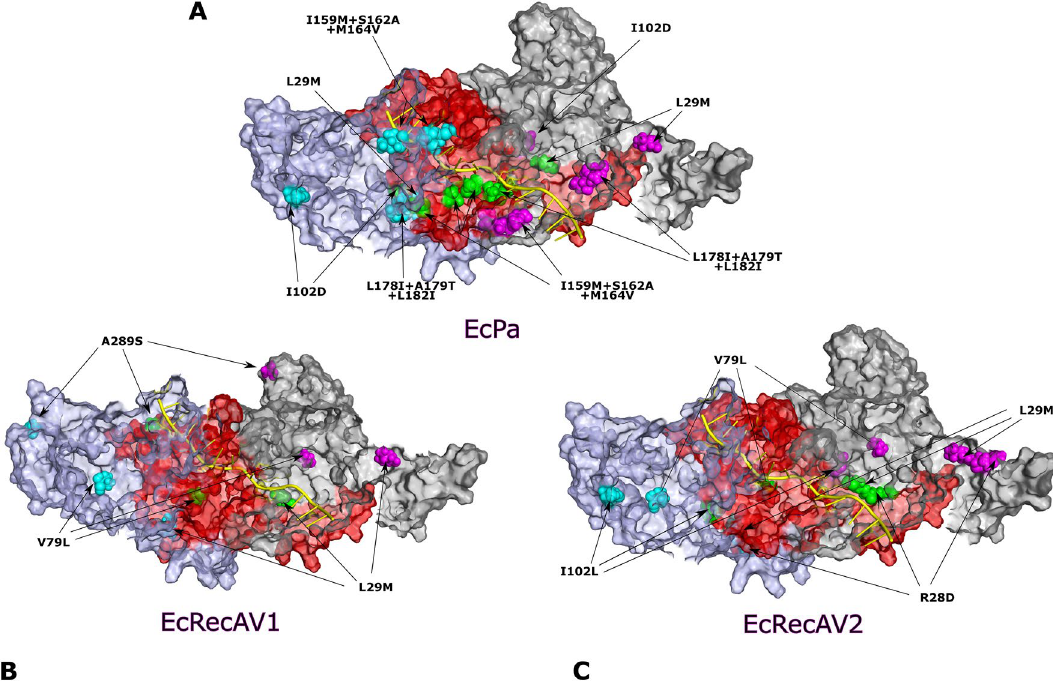
Figure 3. 3D structure of RecA variant-ssDNA nucleoprotein filaments. Side view of the 3D structure of 3 monomers of an E. coli RecA-ssDNA nucleoprotein filament. Each monomer is coloured violet, red and grey. Amino acids modified in the different variants are represented as spheres and are coloured cyan for the violet monomer, green for the red monomer and pink for the grey monomer. The mutations are indicated by arrows. ssDNA is shown in yellow. ( A ) The EcPa variant includes the L29M, I102D, I159M + S162A + M164V and L178I + A179T + L182I mutations. ( B ) The EcRecAV1 variant includes the L29M, V79L and A289S mutations. This mutant is also truncated by 17 amino acids at the C-tail. As the tail is disordered, it does not appear in the 3D structure. ( C ) The EcRecAV2 variant includes R28D, L29M, V79L and I102L. The figure was generated using the PyMol program 18 and models provided by Prentiss and Prevost 19